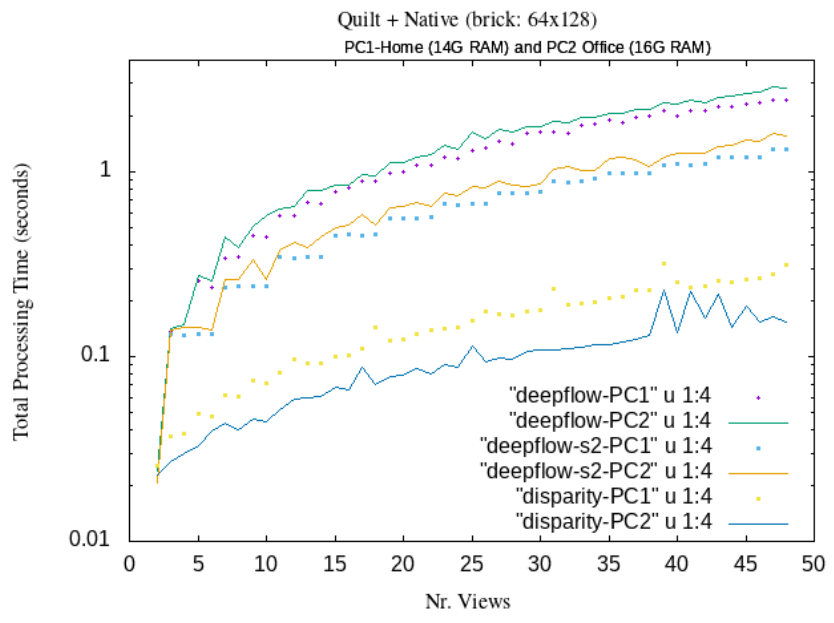
Figure 7. Computational timing of the MORPHOLO mapping procedure from the stereoscopic image to the Native output image on Linux Ubuntu O.S. for different number of